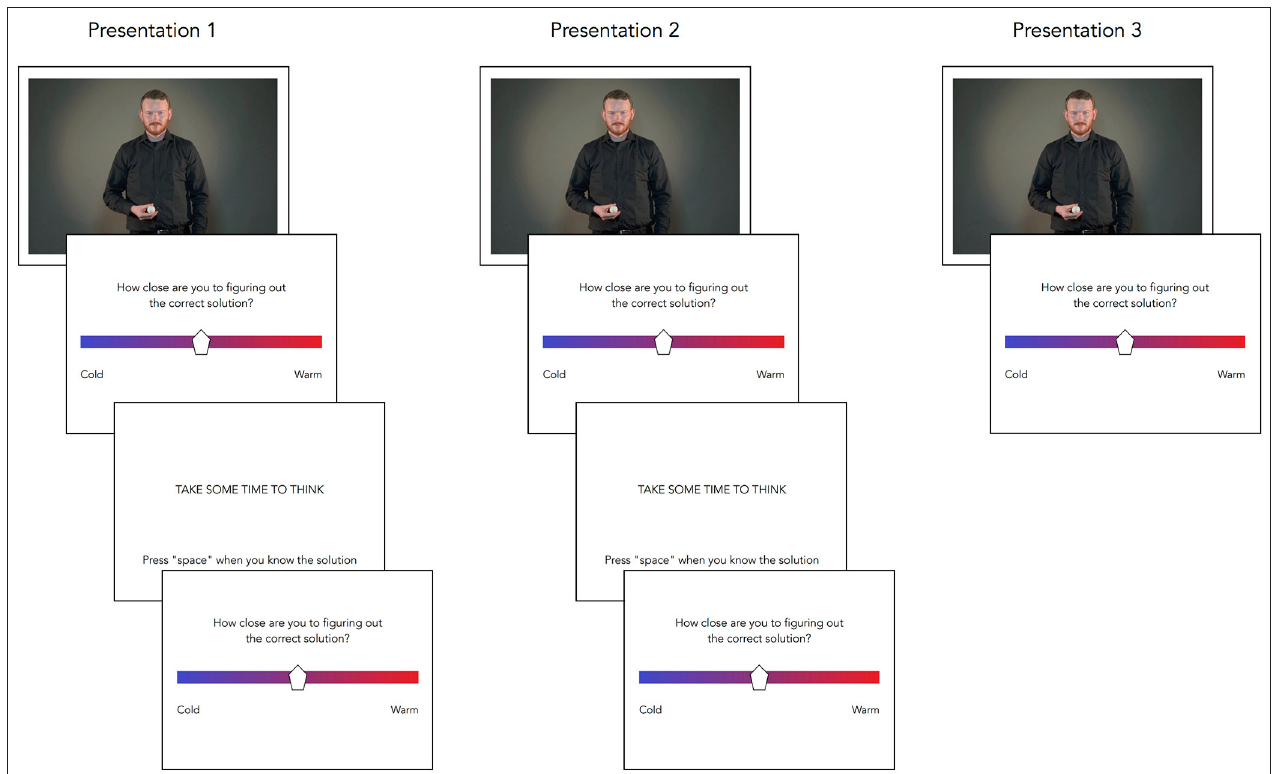
FIGURE 4 | A picture sequence of a trial of the main problem solving task. Each trial consisted of up to 3 presentations of the video, up to 5 warmth ratings, up to 2